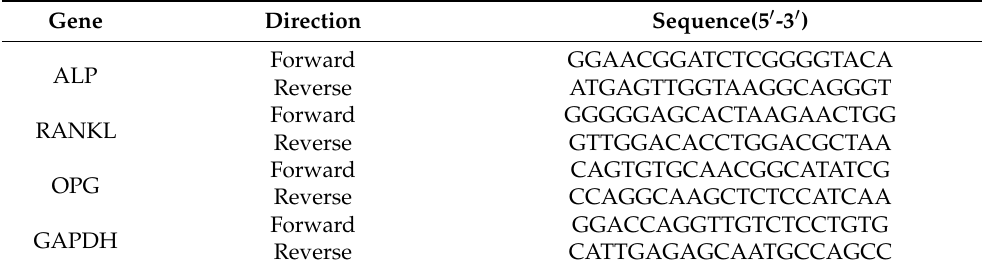
Table 2. The primer sequences of osteoblasts for